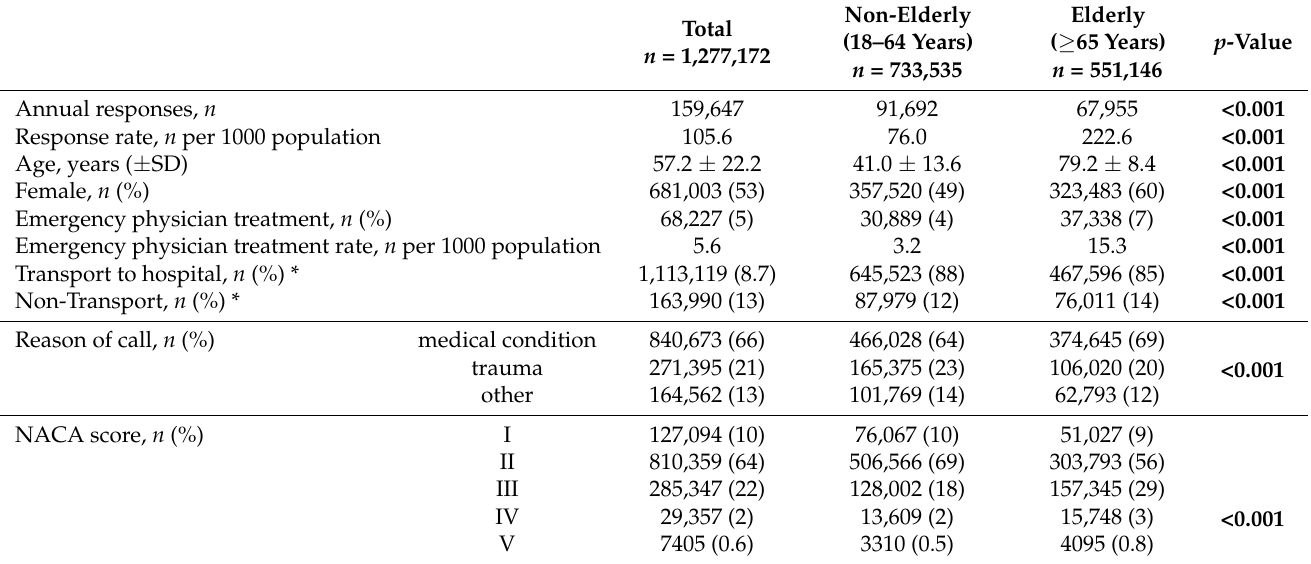
Table 1. Characteristics of elderly versus non-elderly patients in demand of EMS care between 2012 and 2019 in